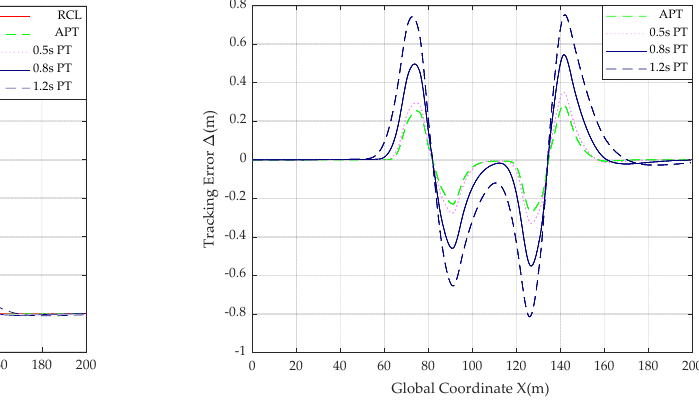
( b ) Comparison of tracking error at 20 m/s with dif ‐ ferent preview times Figure 22. Comparison of trajectories and tracking error with different preview times at 20 m/s. Table 6. Maximum offsets and minimum offsets for different preview times and different speeds for road segment three. Speed (m/s) Adaptive Preview Time (m) 0.5 s Preview Time (m)